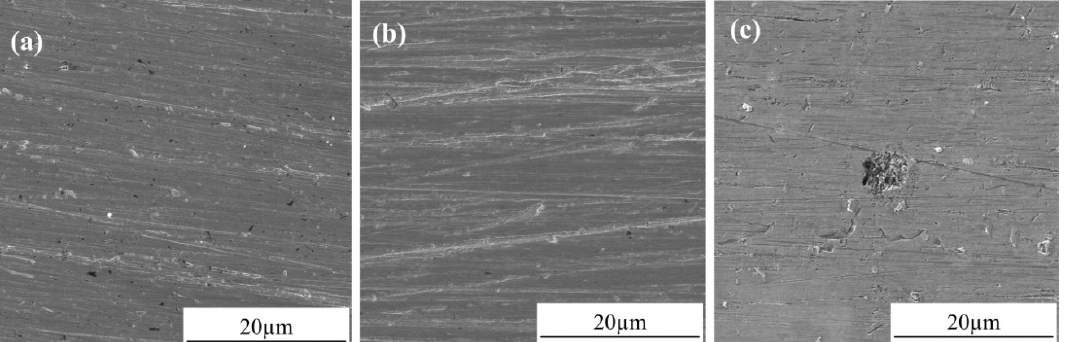
Figure 3. Micro-corrosion morphology of the samples without stress at 150 ◦ C, with di ff erent experimental conditions ( a ) P H2S = 0.1 and P CO2 = 4 MPa, ( b ) P H2S = 0.5 and P CO2 = 4 MPa and ( c ) P H2S = 1 and P CO2 = 4 MPa.